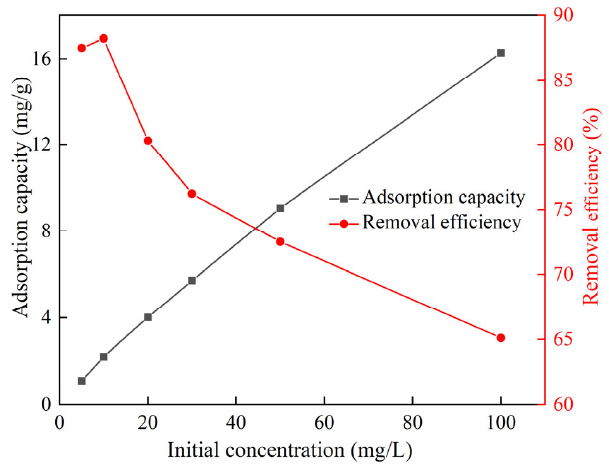
Figure 11. Influence of initial ammonia nitrogen concentration on adsorption.